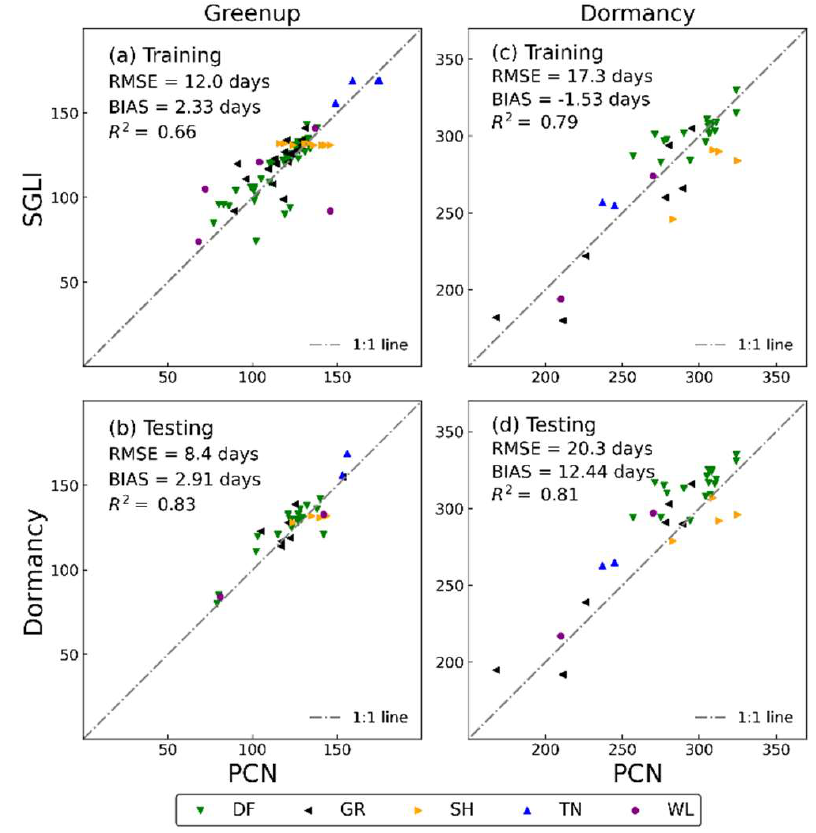
Figure 3. Comparison of green-up and dormancy dates from SGLI and PCN observation by land cover types (DF: deciduous forest; GR: grassland, SH: shrub; TN: tundra; WL: wetland). ( a , c ) are comparisons at the 81 sites used to confirm the thresholds; ( b , d ) are comparisons at the 34 sites used to test the thresholds.